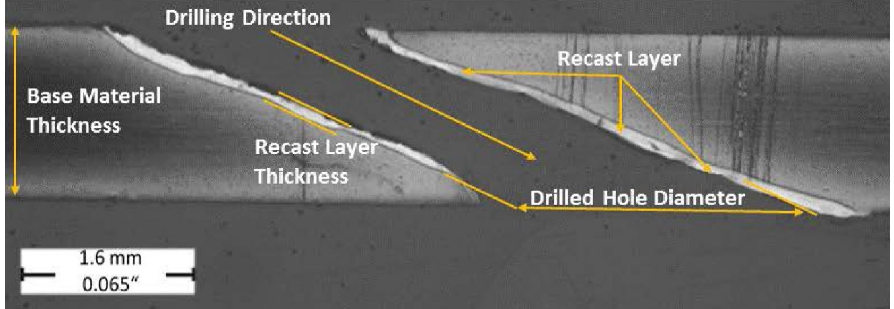
Table 4. Values of the average recast layer thickness.